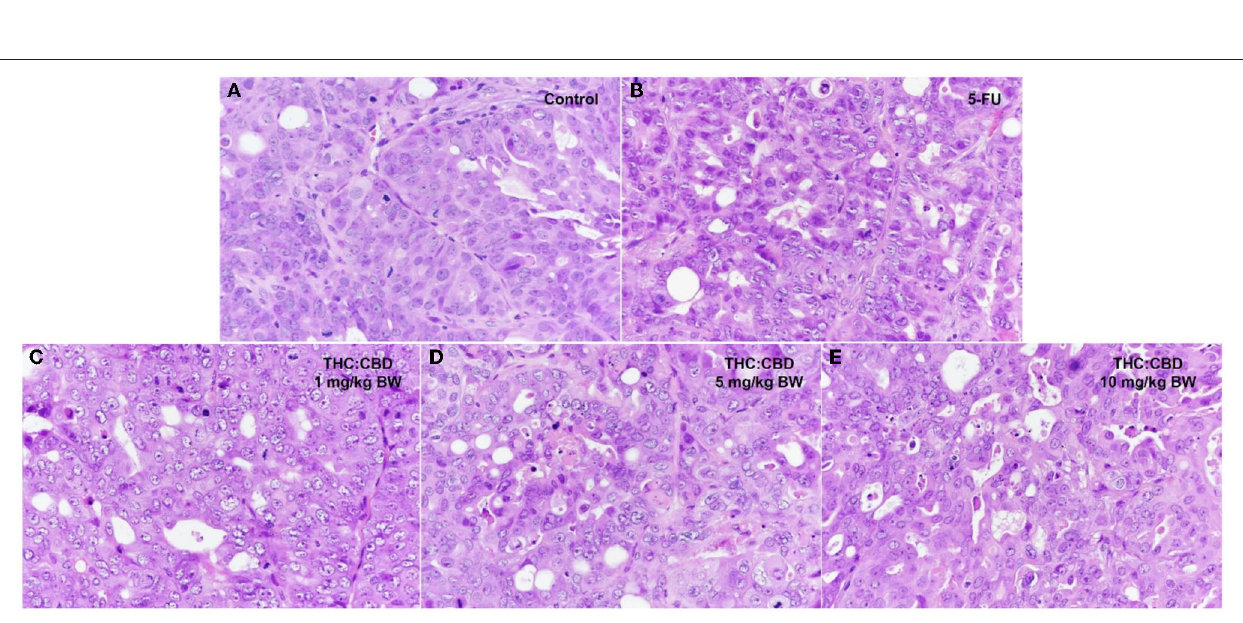
group (3.35 ± 0.489) ( P < 0.05) ( Table 4 ). Caspase-3